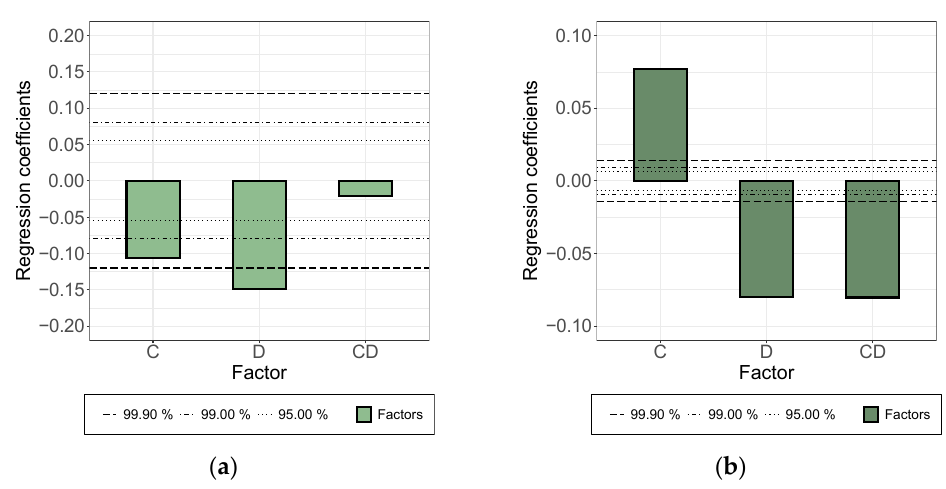
Figure 4. Effects of factors C, D, CD, on electrical conductivity of ( a ) the suspension and ( b ) the formed dry layer, for three-roll-mill dispersing step. C: increasing rotational speed of roller, D: increasing gap width, CD: interaction.